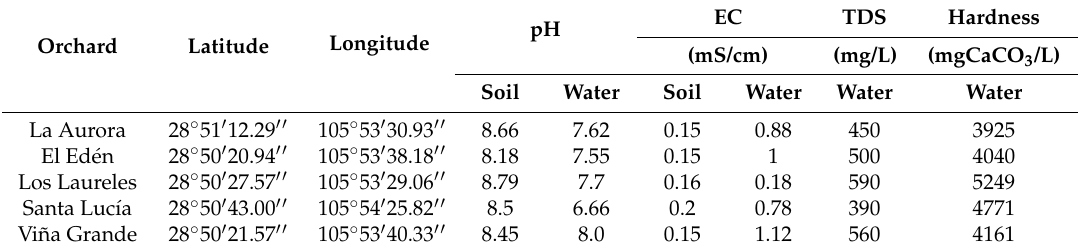
Table 1. Chemical parameters measured in situ in the different soils and irrigation water of the orchards.